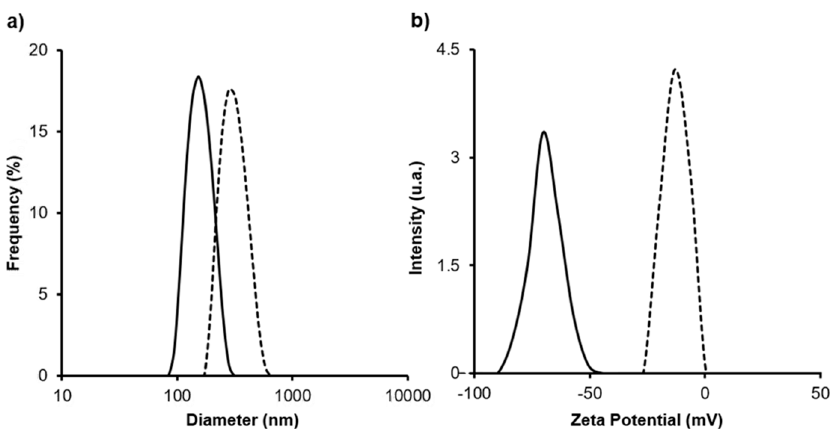
Figure 1. ( a ) Size distribution and ( b ) zeta potential of liposome (solid line) and PTX-ANA co-loaded liposome (dashed line).